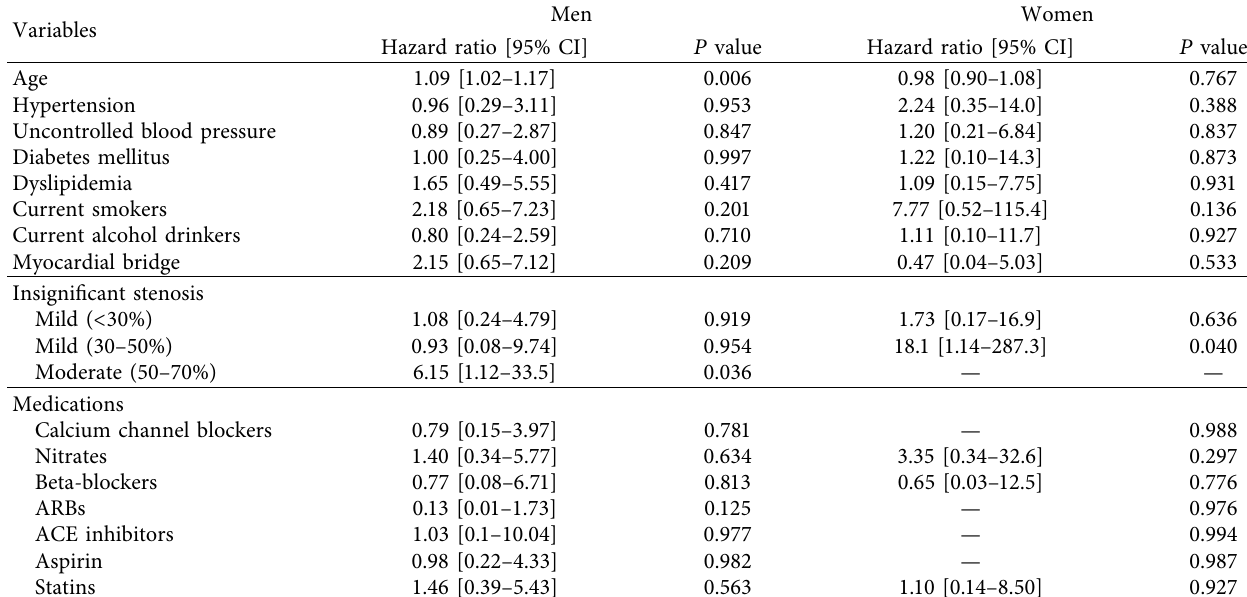
Figure 1: Forest plot of odds ratio and 95% confidence intervals for acetylcholine-induced coronary artery spasm by univariate logistic regression analysis. CI, confidence interval. Table 5: Independent risk factors of MACE in CAS patients at follow-up period by multivariable Cox-proportional hazard ratio model